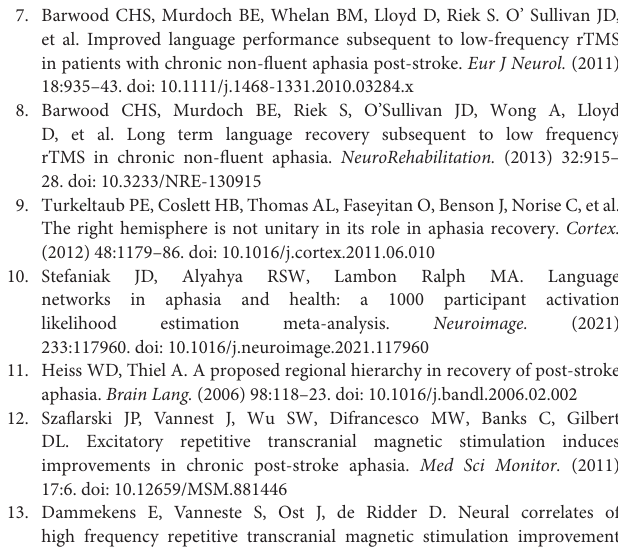
Supplementary Figure 1 | Transcranial magnetic stimulation (TMS) and Navigation system. The system consists of a TMS chair, an optical digitizer, a Navigation computer, a TMS machine, and a figure-8 shape coil. Supplementary Figure 2 | T2-weighted FLAIR axial brain MRI images of patient number 2, showing large chronic infarction in the left fronto–temporo–parietal lobe. From left to right and top to bottom. R, right; L, left. Supplementary Table 1 | Subsection scores of K-WAB in 5